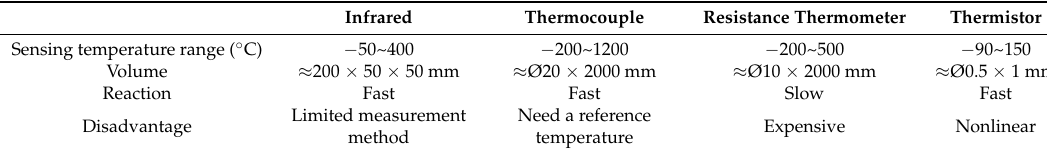
Table 1. The comparison table of the temperature sensor methods.